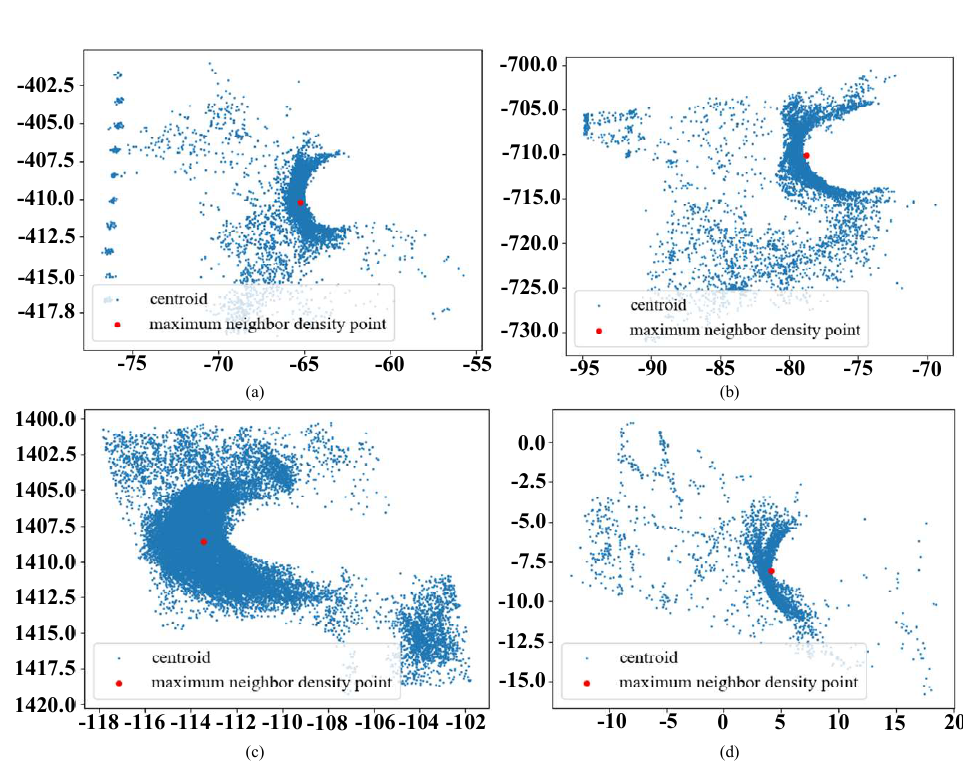
Figure 8. Maximum neighbor density point in four samples. ( a ) Sample 1 of Figure 6a; ( b ) Sample 2 of Figure 6b; ( c ) Sample 3 of Figure 6c; ( d ) Sample 4 of Figure